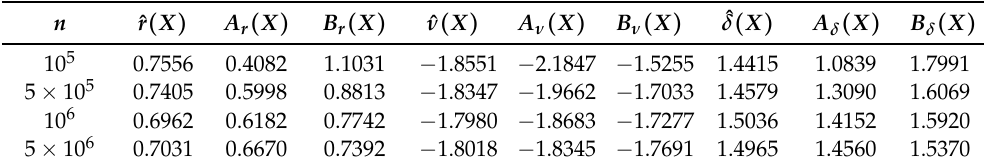
Table 4. Examples of estimates for the parameters and boundaries of confidence intervals for a